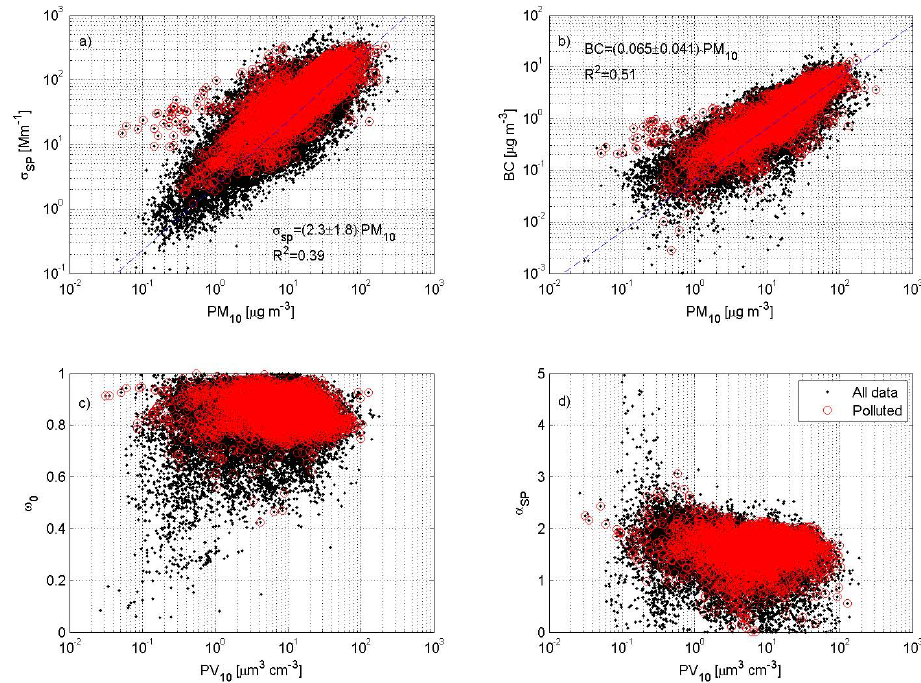
Fig. 9. Relationships between aerosol optical parameters and integrated volume or mass concentration. (a) Scattering coefficient σ SP vs. PM 10 mass concentration calculated from the PM 10 volume concentration assuming the particle density 1.5gcm − 3 . The error value of the slope is the standard deviation obtained from a linear regression of scattering versus PM 10 , (b) black carbon concentration m (BC) vs. PM 10 mass concentration calculated from the PM 10 volume concentration assuming the particle density 1.7gcm − 3 . The error value of the slope is the standard deviation calculated as in (a, c) single scattering albedo as a function PV 10 concentration, and (d) ˚Angstr¨om exponent as a function PV 10